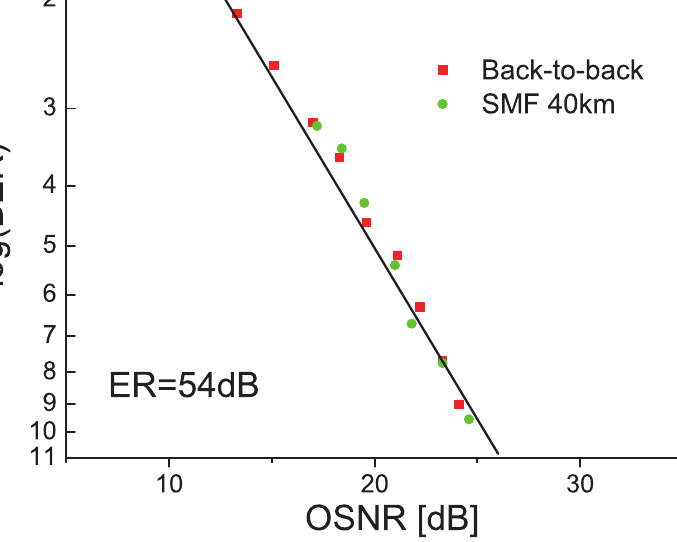
Figure 16. Bit error ratio for back-to-back and 40 km SMF